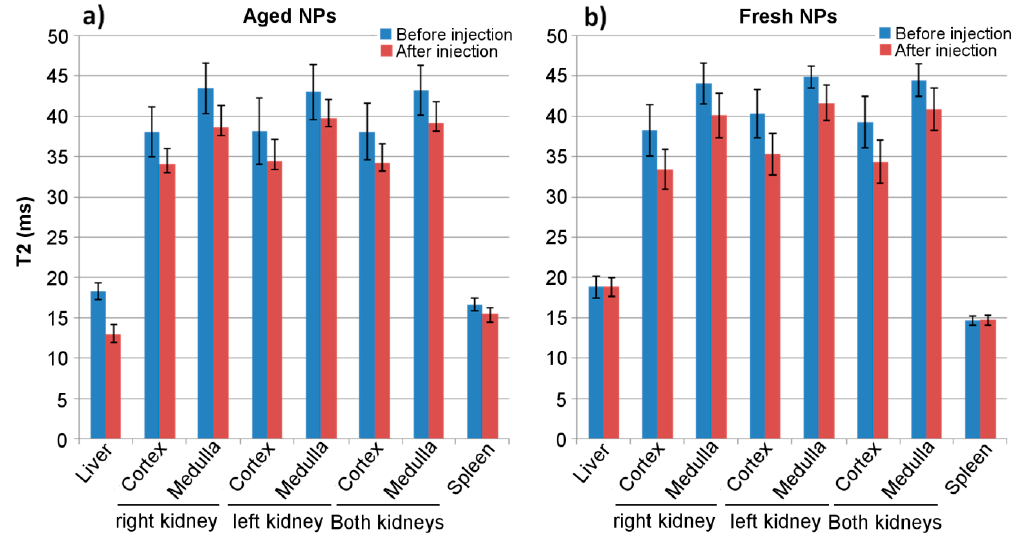
Figure 7. Mean ( ± SD) T2 relaxation values obtained for different organs before (blue) and after (red) injection of the aged ( a ) and fresh ( b ) nanoparticles.